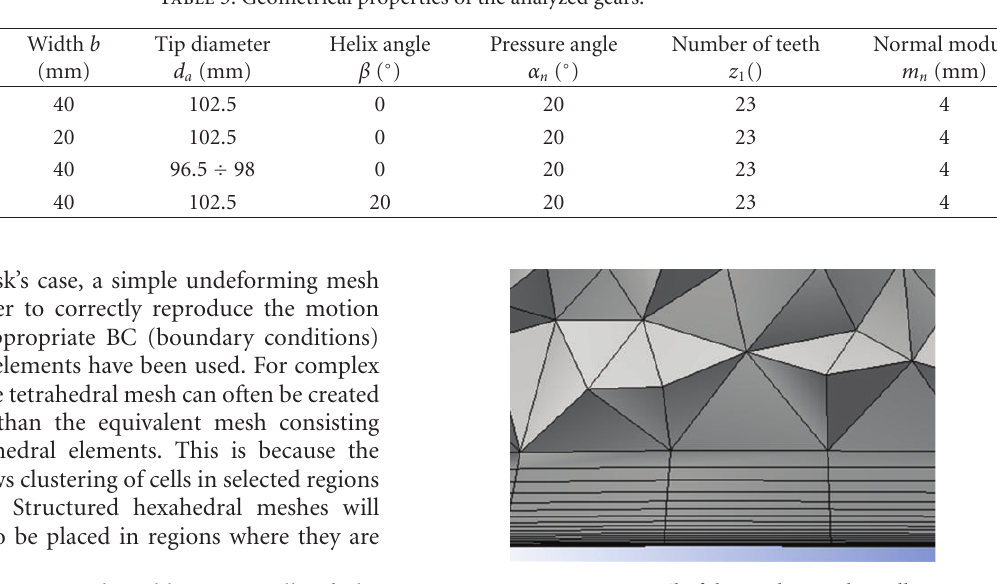
Figure 3: Detail of the mesh near the wall.